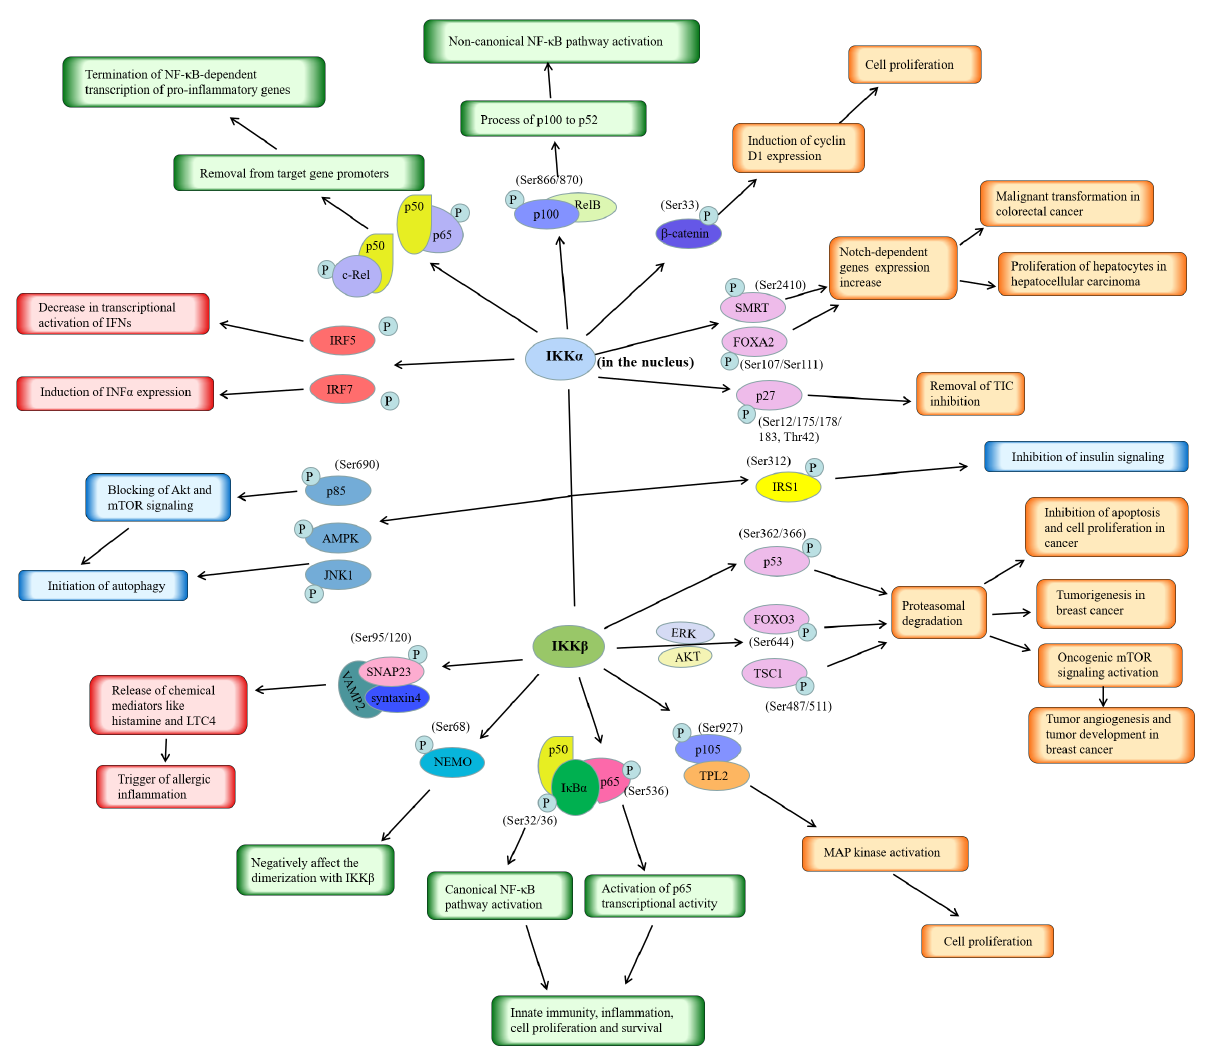
Figure 2. The substrates of IKKα and IKKβ and the related functions. In addition to activation of the canonical and non-canonical NF-κB pathways through phosphorylation of the IκBs, IKKα and IKKβ are now thought to phosphorylate a number of other substrates. And in turn, other than immune responses, IKKα and IKKβ are also important signaling proteins for critical cellular processes associated with several diseases like cancer. For more information see